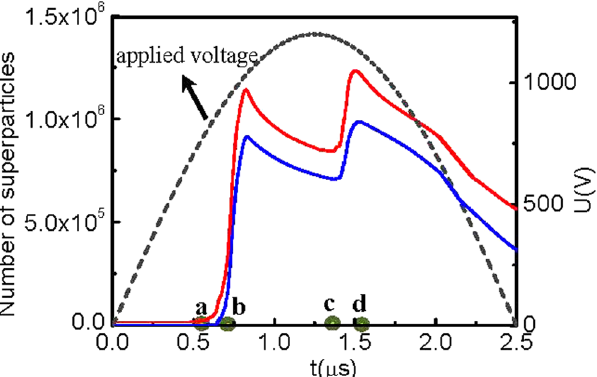
Figure 2. Time trace of the number of superparticles in the gas gap, where the red line is for He + and the blue line is for electrons. One superparticle corresponds to 10 7 real particles. The green circles ( a to d ) indicate the times discussed later in Figs 3 to 4. The times are t = 0.62 μ s, 0.72 μ s, 1.34 μ s, 1.51 μ s,